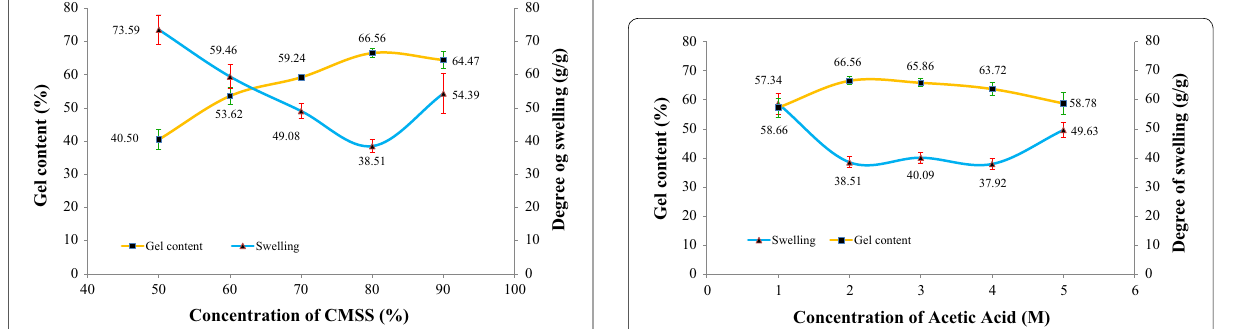
Fig. 4 Effect of acetic acid concentration on gel content and degree of swelling of CMSS–acid